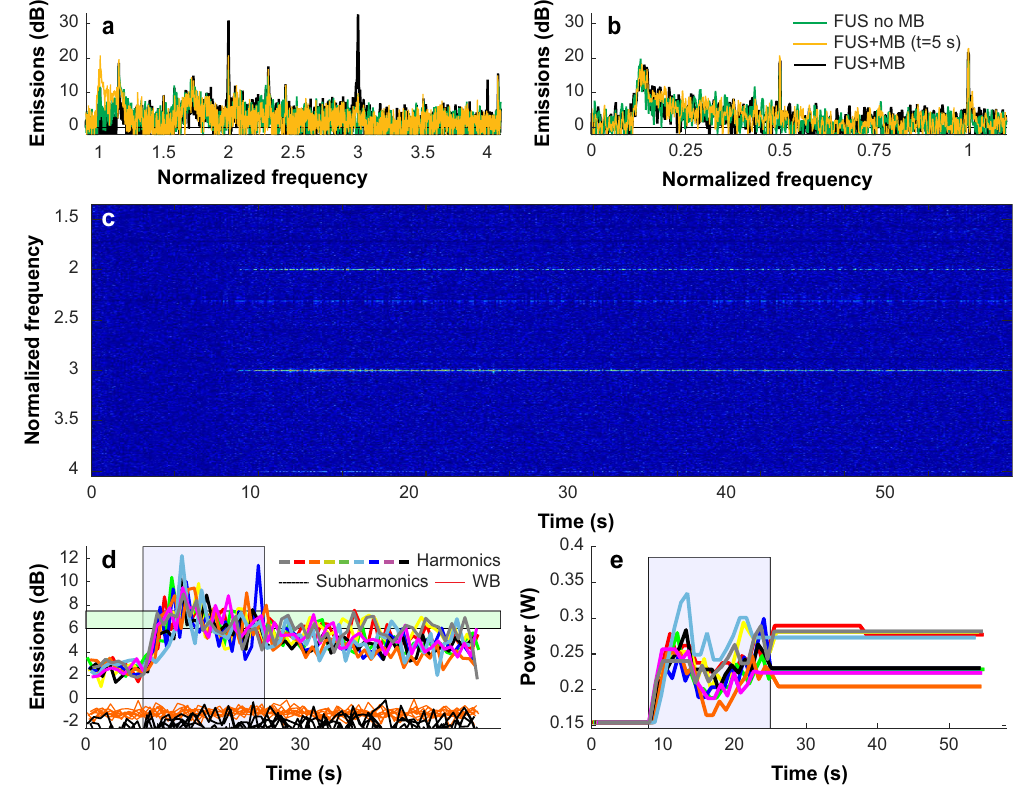
Figure 2. Example acoustic emission obtained during a volumetric sonication with closed-loop feedback control. ( a , b ) Example spectra obtained during individual bursts during sonications with and without microbubbles (MB) for the two passive cavitation detectors. Spectra obtained early in the sonication before the microbubbles arrived the brain were similar to those obtained in prior sonications performed without microbubbles. With microbubbles, large and obvious enhancement at the second and third harmonics was observed ( a ), while subharmonic emission was unchanged ( b ). Data are shown in dB relative to the noise floor obtained before the sonication started. ( c ) Spectrogram obtained during this sonication. Here, the data is shown in dB relative to the mean spectra of the first 8 seconds during the sonication with microbubbles. Normalizing the data to spectra obtained before the microbubbles arrived in the brain removed everything except for the harmonic emissions, highlighting the unique signals produced by the microbubbles in the ultrasound field. ( d ) Magnitude of the harmonic, subharmonic, and wideband (WB) emissions plotted as a function of time during the 9 locations targeted in a volumetric sonication. The magnitude of the harmonic emissions were similar for the 9 locations, and all achieved the controller goal of 6–7.5 dB above the noise floor (blue region). Some overshoot occurred. Only small changes were observed in the subharmonic emissions, and no wideband emissions were detected. ( e ) Acoustic power level as a function of time for the 9 locations. During the control period (green region), the power at each location was modified based on the magnitude of the harmonic emissions. After this time, the power level was fixed to the average value of all the bursts that were within the controller goal. In cases where subharmonic or wideband emissions above the noise floor were detected, the power level was reduced by 40% and fixed for the remainder of the